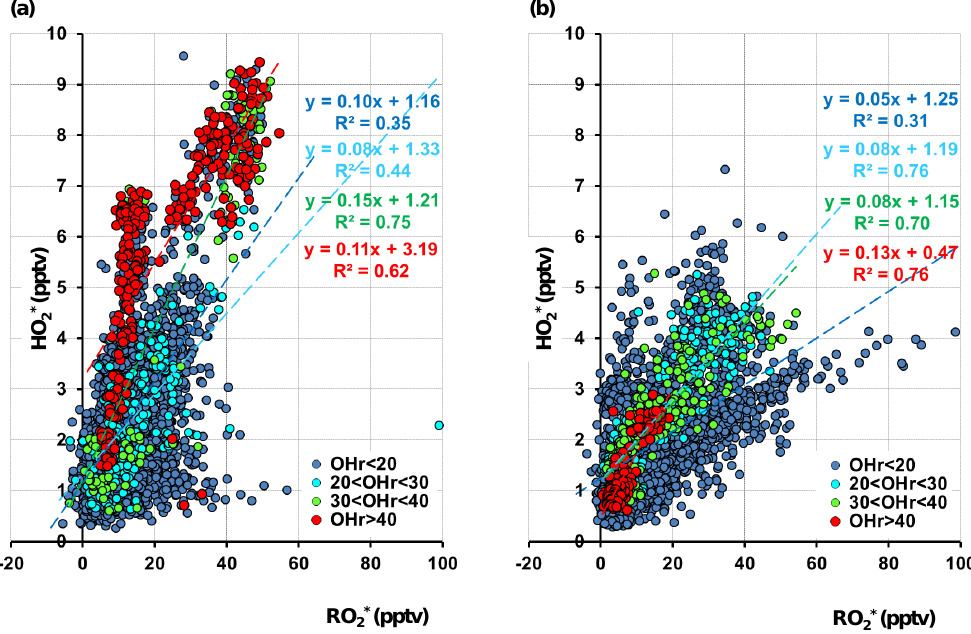
versus RO ∗ for different OH reactivities (OHr in s − 1 ) measured during DOMINO. Data for (a) photochemical (06:00– Fig. 13. HO ∗ 2 2 17:00UTC) and (b) non-photochemical (00:00–06:00 and 17:00 to 24:00UTC) radical production are plotted